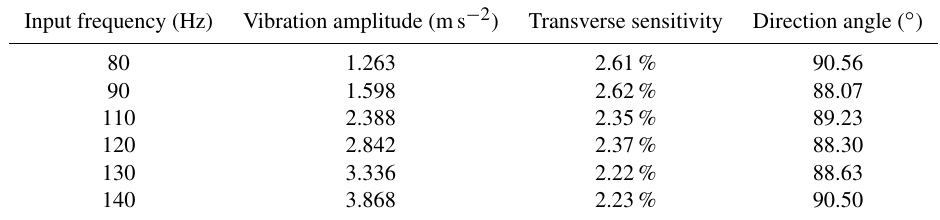
Figure 5. Experimental results under test at 120Hz: (a) show the output; (b) show the polar figures of the relative transverse sensitivity. Table 1. Results of testing transverse sensitivity under various input